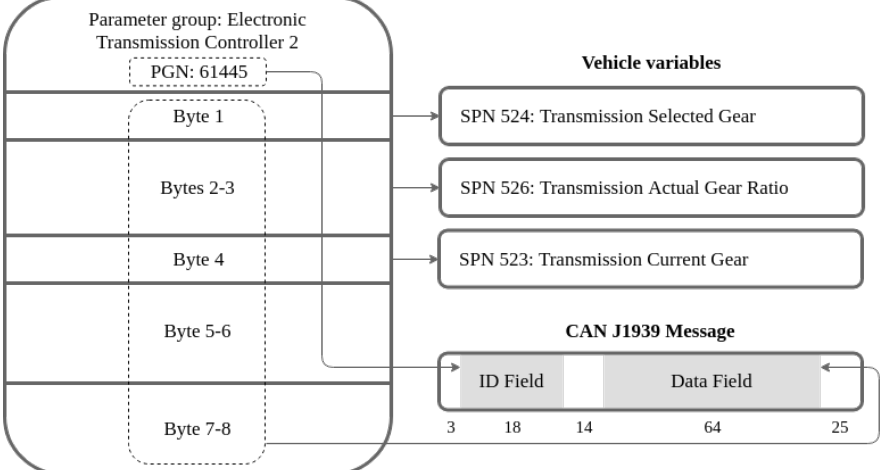
Figure 3. J1939 PGN 61443 message, which contains actual gear ratio, selected gear and current